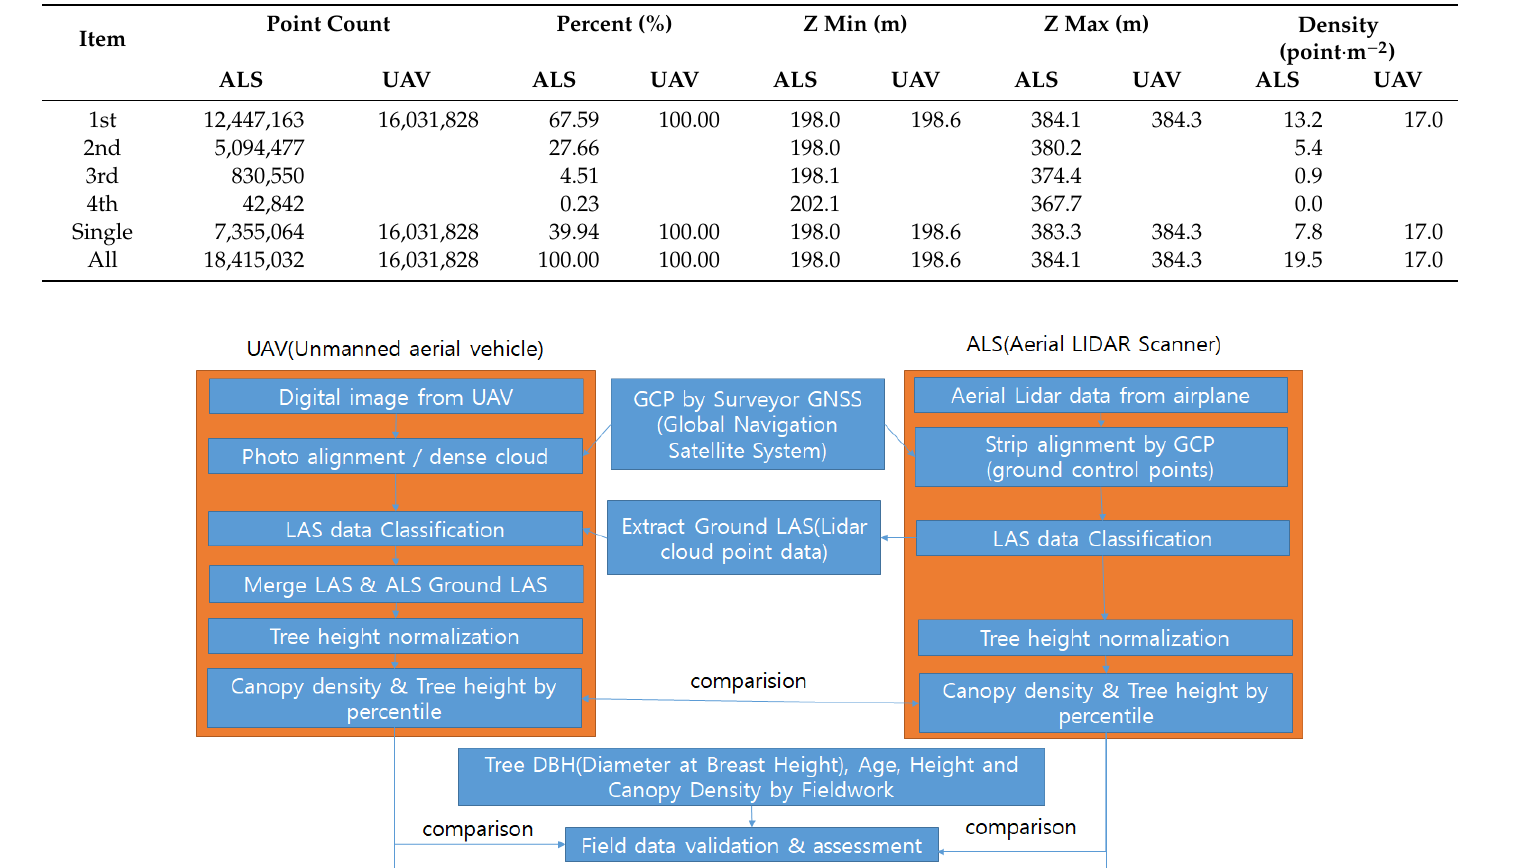
Table 1. Aerial Light Detection and Ranging (LIDAR) Scanner and UAV point clouds statistic.